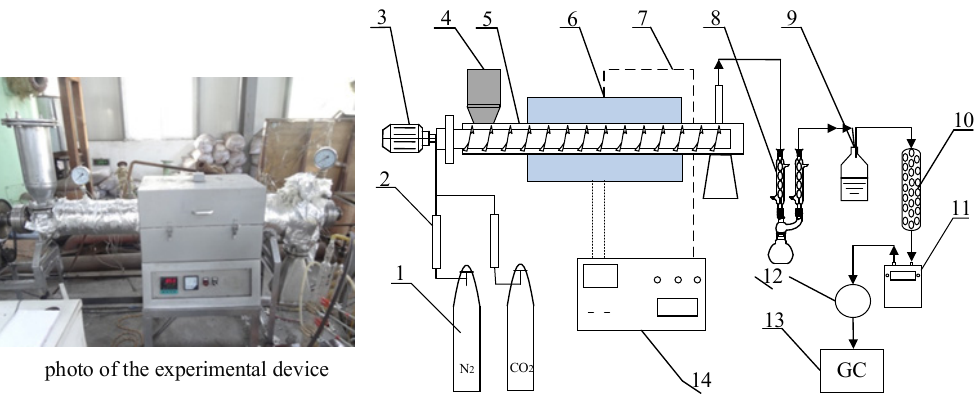
Figure 1. Schematic diagram of experimental apparatus. 1—gas cylinder; 2—mass flow meter; 3—motor; 4—feed-bunker; 5—spiral propelled tubular reactor; 6—Electric heating furnace; 7—Thermalcouple; 8—Spherical condenser; 9—water filter; 10—galss fiber filter; 11—gas meter; 12—sampling bag; 13—gas chromatograph; 14—temperature control.